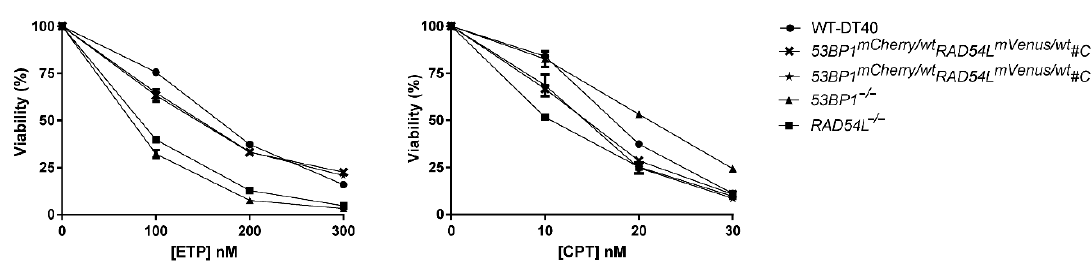
Figure 3. The viability of biosensor clones following exposure to DNA-damaging agents demonstrated the same phenotype as wild-type DT40. The experiments were reproduced with biologically independent replicates. Data are shown as the mean ± standard deviation from one experiment. The error bars are shorter than the height of the symbol in some points. Definitions: ETP, etoposide; CPT, camptothecin.